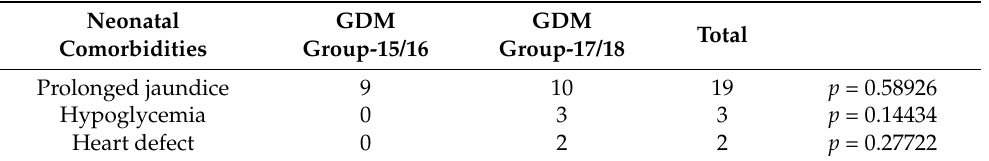
Table 8. Neonatal